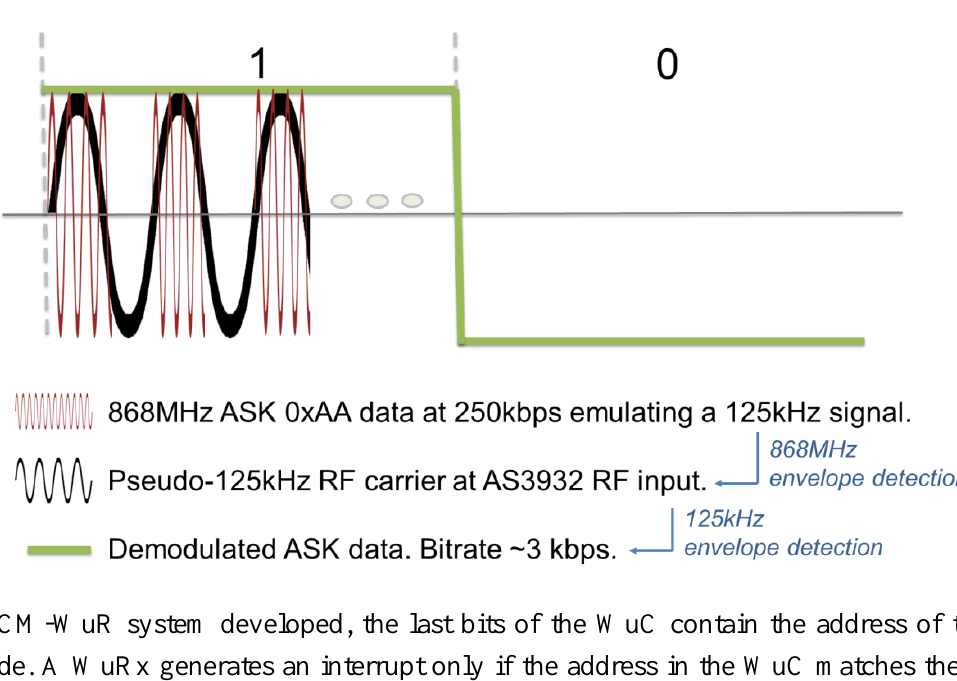
Figure 5. Bits of a WuC in a SCM-WuR